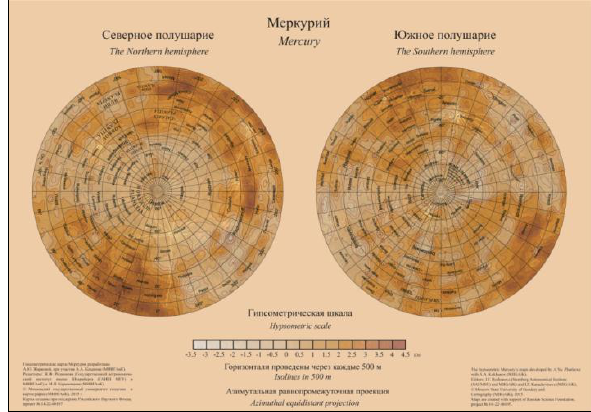
Figure 4. Pamphlet for the Mercury Globe, accompanied by a description of generic hypsometric